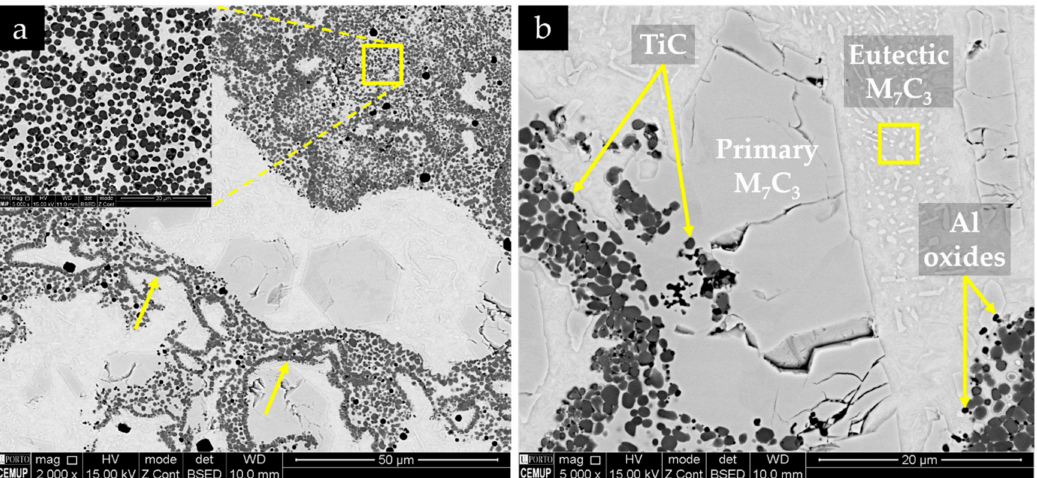
Figure 14. SEM-BSE images of the microstructure of the composite zone, showing ( a ) TiC particle clusters, highlighted in the image; ( b ) with higher magnification, coarse primary and eutectic M 7 C 3 carbides, and Al oxides (black